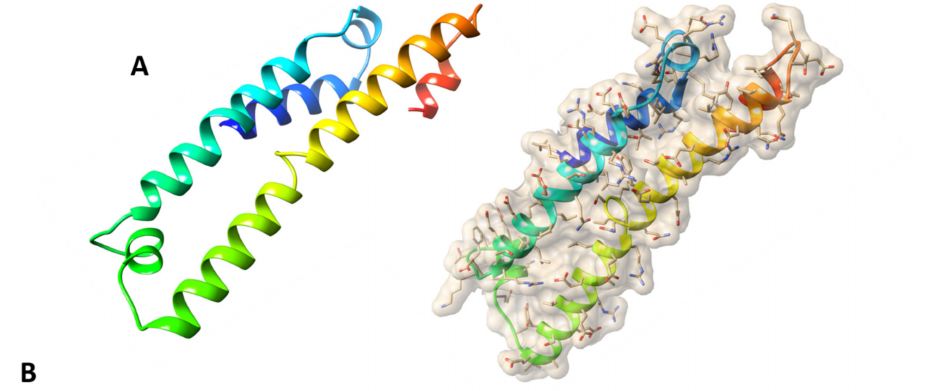
Figure 3. Vaccine structure modeling and validation. ( A ) The 3D model of a multi-epitope vaccine construct, obtained by Swiss Model. ( B ) Vaccine construct sequence with adjuvants (EAAAK-EAAAK (shown in brown color), G-linker (shown in purple), H-linker (shown in blue), and PADRE Sequences (shown in red).